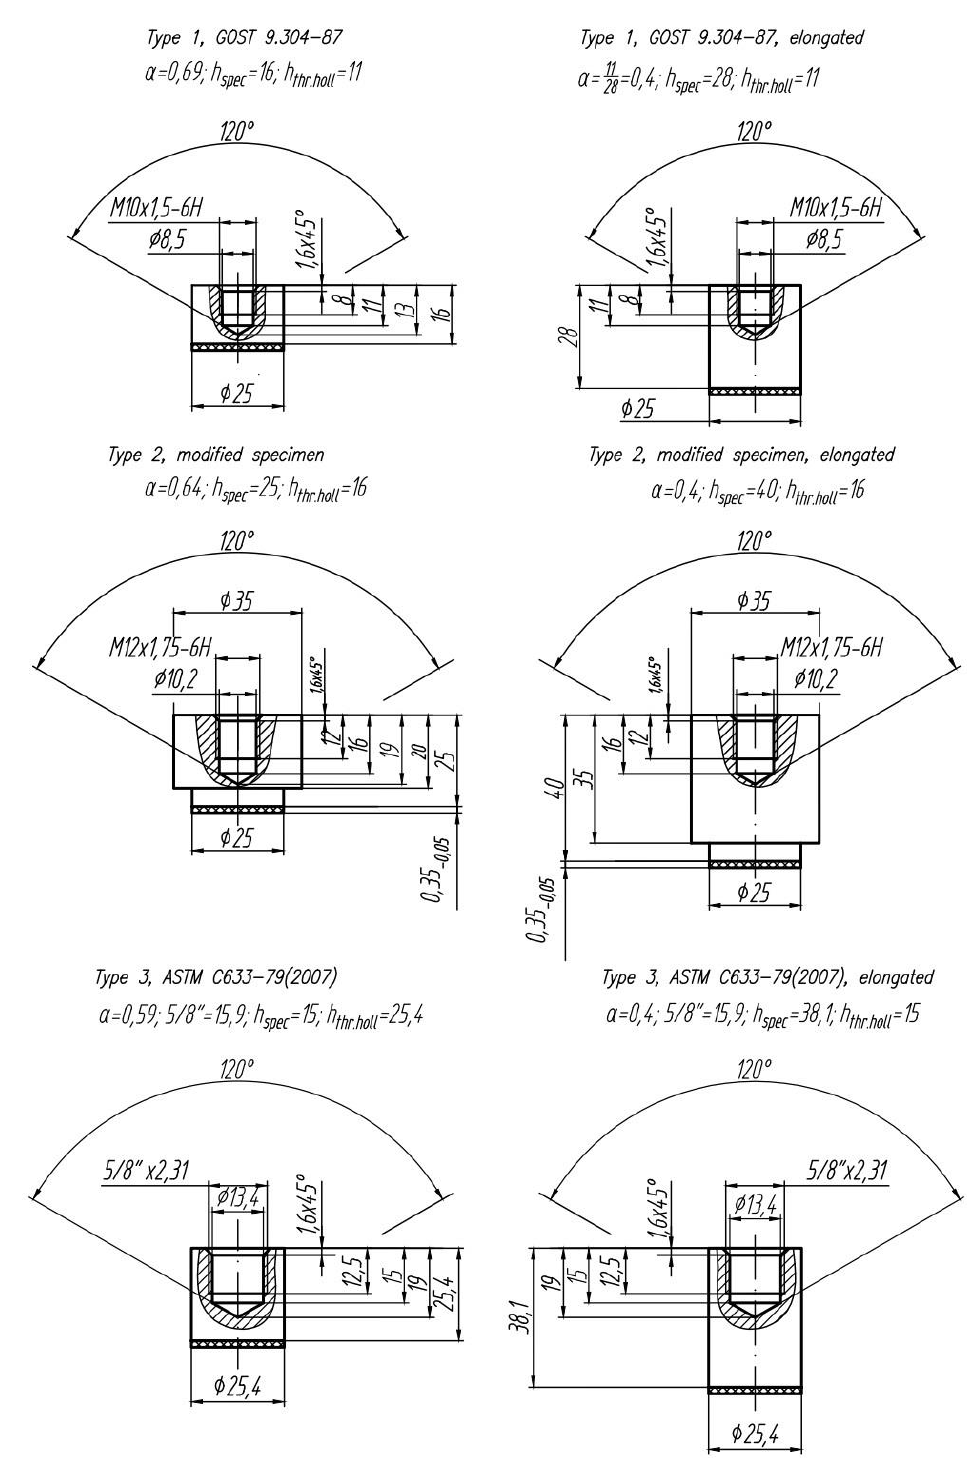
Figure 2. Six types of cylindrical specimens used to evaluate the bond strength of the thermal spray